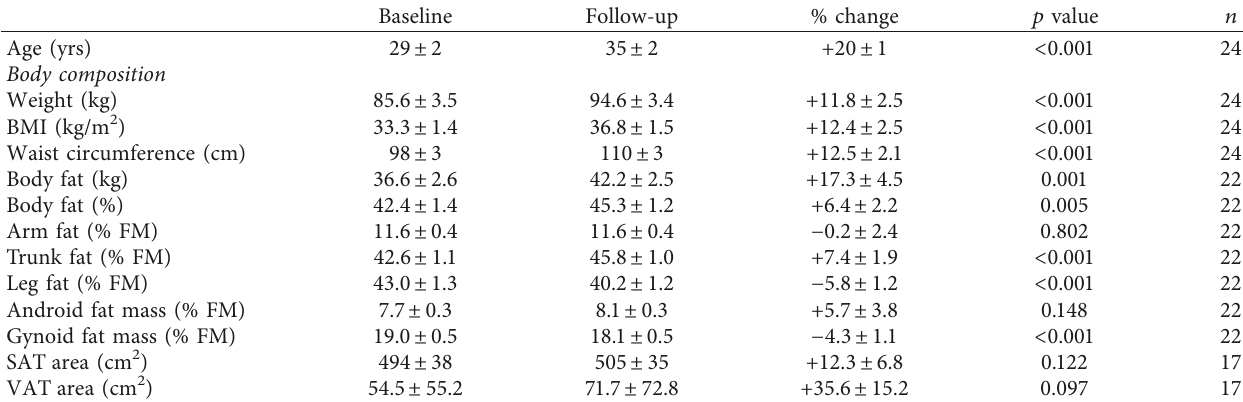
Table 1: Changes in body composition and body fat distribution.